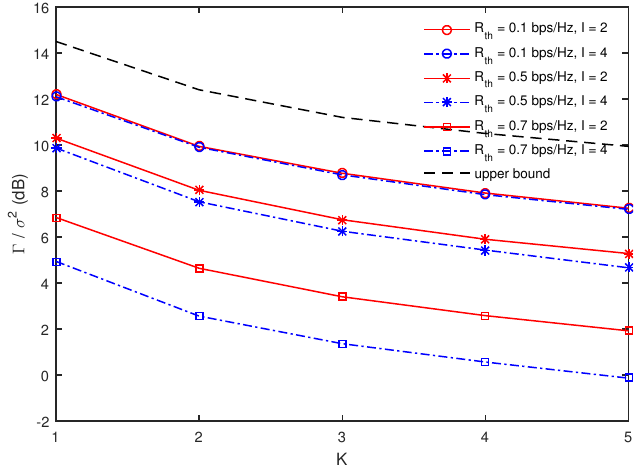
Figure 4. Comparison of minimum harvested energy as a function of K for different values of R th and I when M = 4, J = 2, and d R = 60